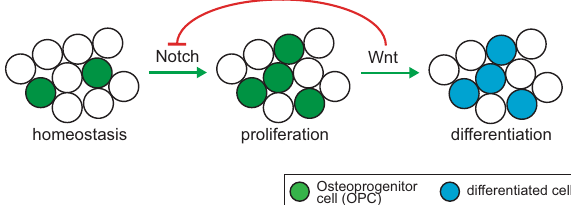
Fig. 6 Graphical summary. After skeletal injury, Notch signaling becomes active and initiates a proliferative response. Days later, canonical Wnt signaling is activated in the injury site, leading to active suppression of Notch signaling and its associated pro- proliferative effect. Wnt signaling then induces